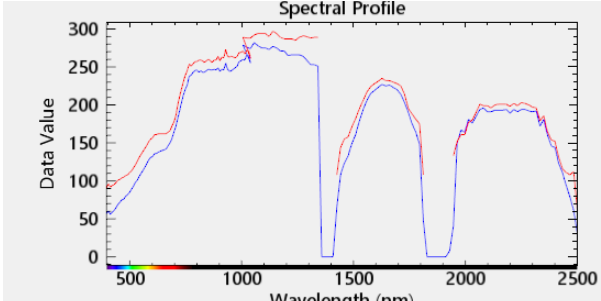
Figure 8 . Spectral curve comparison of ZY1-02D bare land